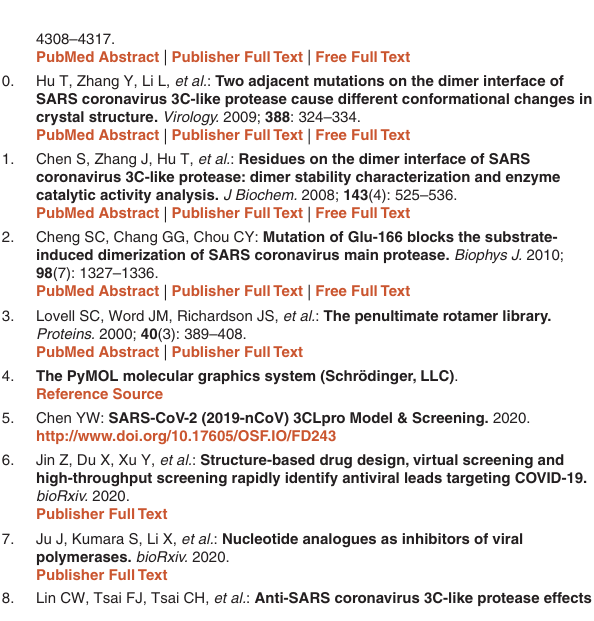
Tab S2-v2.docx (The results of virtual screening of drugs on the active site of SARS-CoV-2 3CL pro crystal structure).